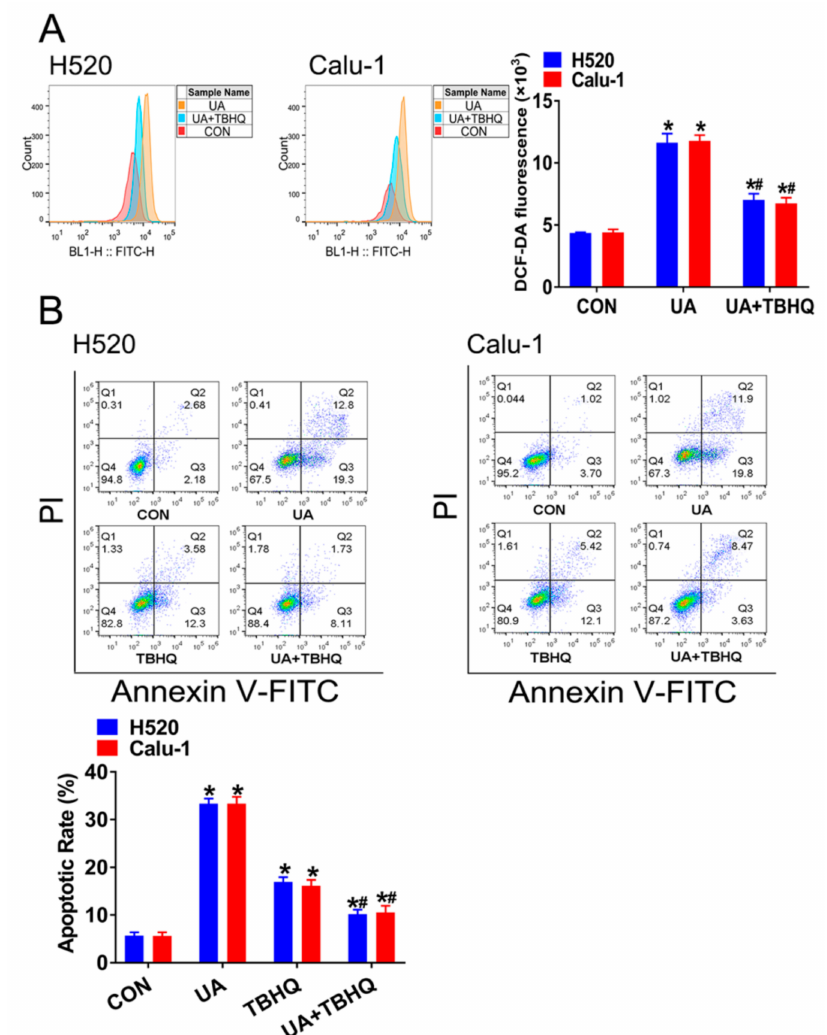
Figure 5. Tert-butyl hydroquinone (tBHQ) reverses ( + )-usnic acid (UA)-induced H520 and Calu-1 cell apoptosis and ROS production. ( A ) TBHQ (20 µ M) reversed UA-induced ROS accumulation. Significantly di ff erent from control group, * p < 0.05, n = 3; # significantly di ff erent from the group of UA, p < 0.05, n = 3. ( B ) TBHQ (20 µ M) blocked UA-induced apoptosis in H520 and Calu-1 cells. Significantly di ff erent from control group, * p < 0.05, n = 3; # significantly di ff erent from the group of UA, p < 0.05, n =